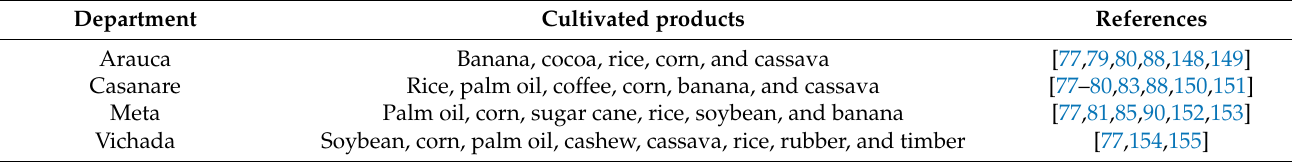
Table 14. Orinoco region.